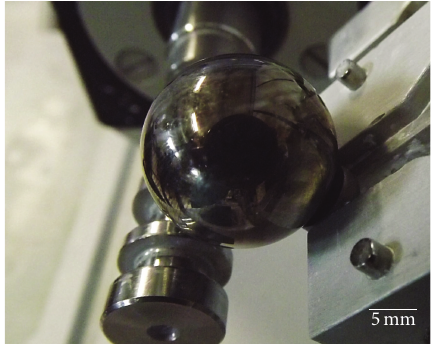
Figure 1: Microabrasive wear test.